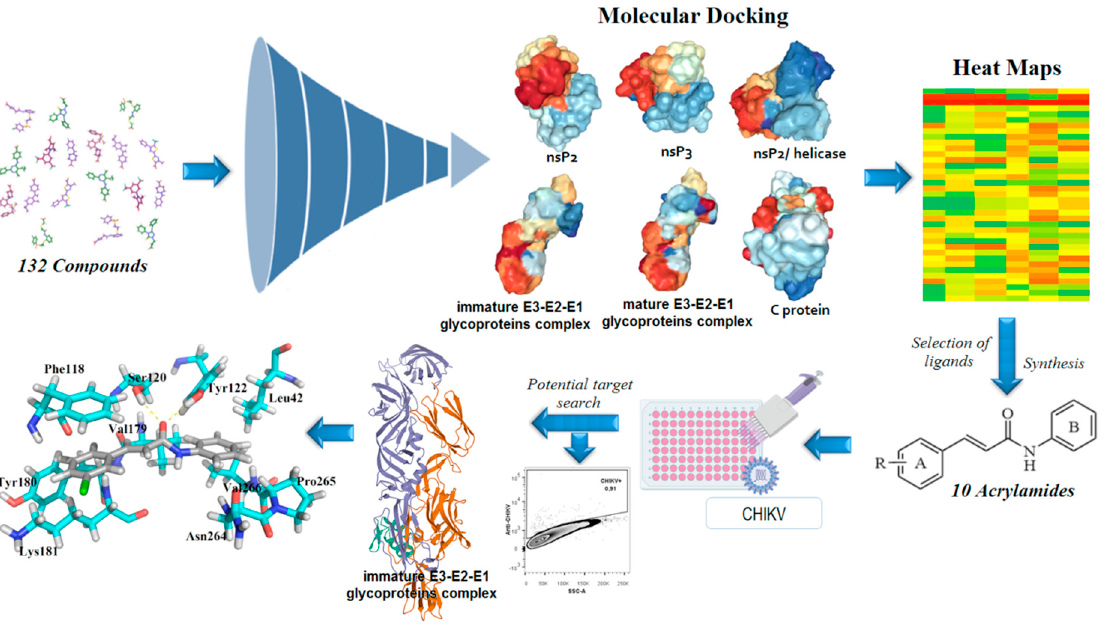
Figure 2. Workflow used to rationally develop acrylamides against the Chikungunya virus (CHIKV). In total, 132 compounds were analyzed toward nsP2 (Protein Data Bank (PDB): 3TRK), nsP2/helicase (PDB: 6JIM), nsP3 (PDB: 3GPO), immature E3-E2-E1 complex (PDB: 3N40), mature E3-E2-E1 complex (PDB: 3N41), and C (PDB: 5H23) proteins. Then, the most promising compounds were synthesized